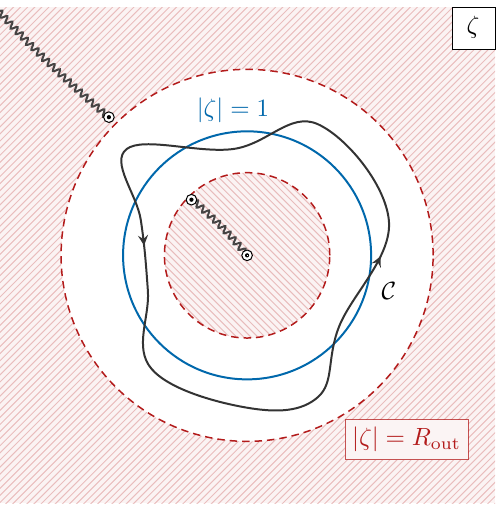
Figure 1. A function which is smooth and real along the unit circle | ζ | = 1 is “inversion symmetric” and analytic within an annulus A (the white region) with radii R out = 1 /R in . These radii are determined by the location of the nearest singularities, pictured here as black lines emanating from the origin and infinity. The function’s Fourier/Laurent coefficients can be found by integrating along a contour C contained within the annulus. Their asymptotic behavior is thus determined by the size of this